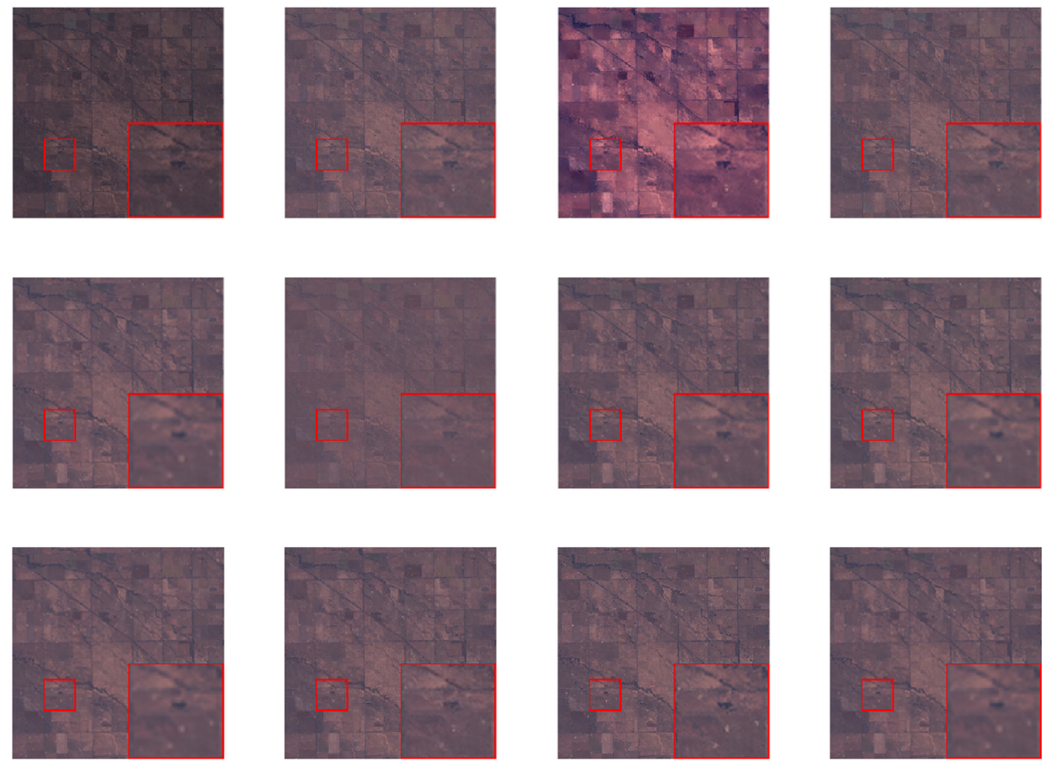
Figure 11. The third group of visualization results.